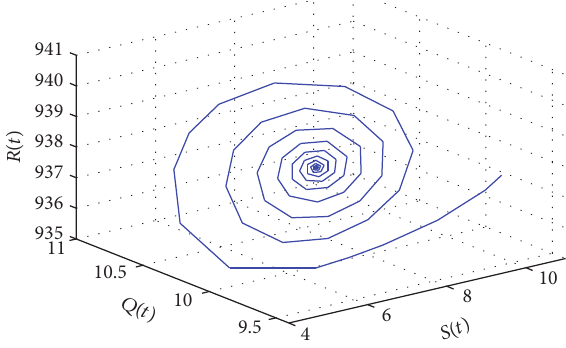
Figure 9: The phase plot of 𝑆 , 𝑄 , and 𝑅 when 𝜏 2 = 1.65 < 1.7852 = 𝜏 20